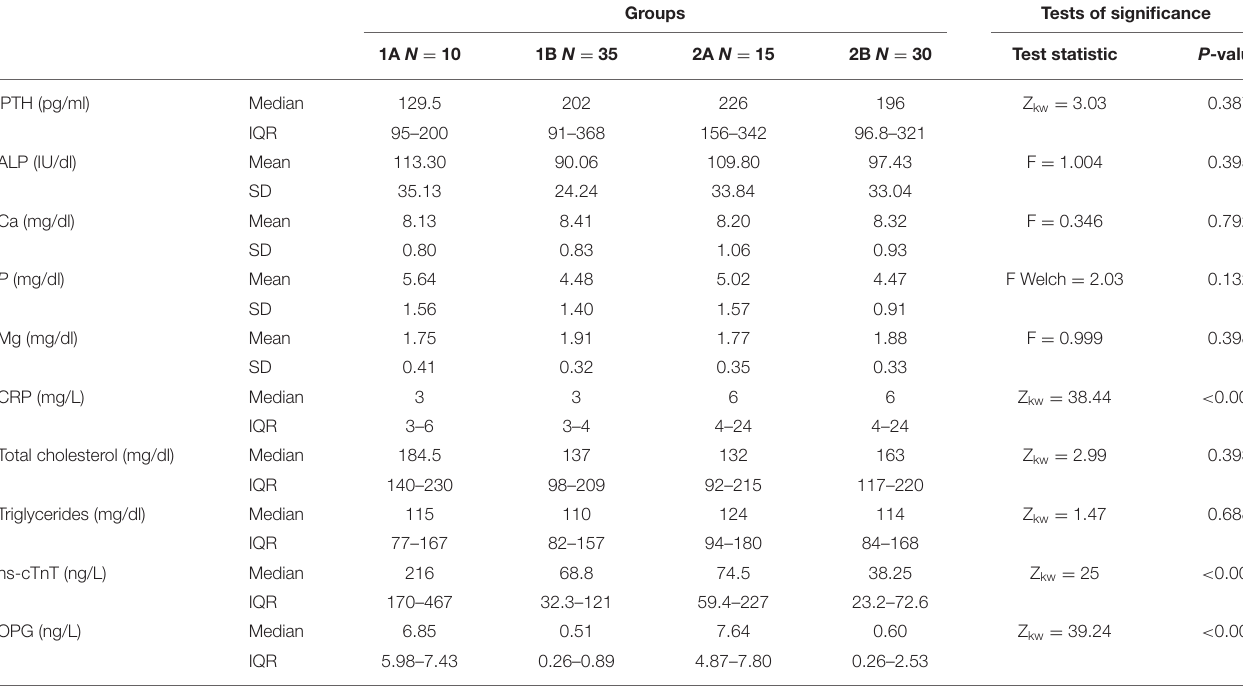
Groups Tests of